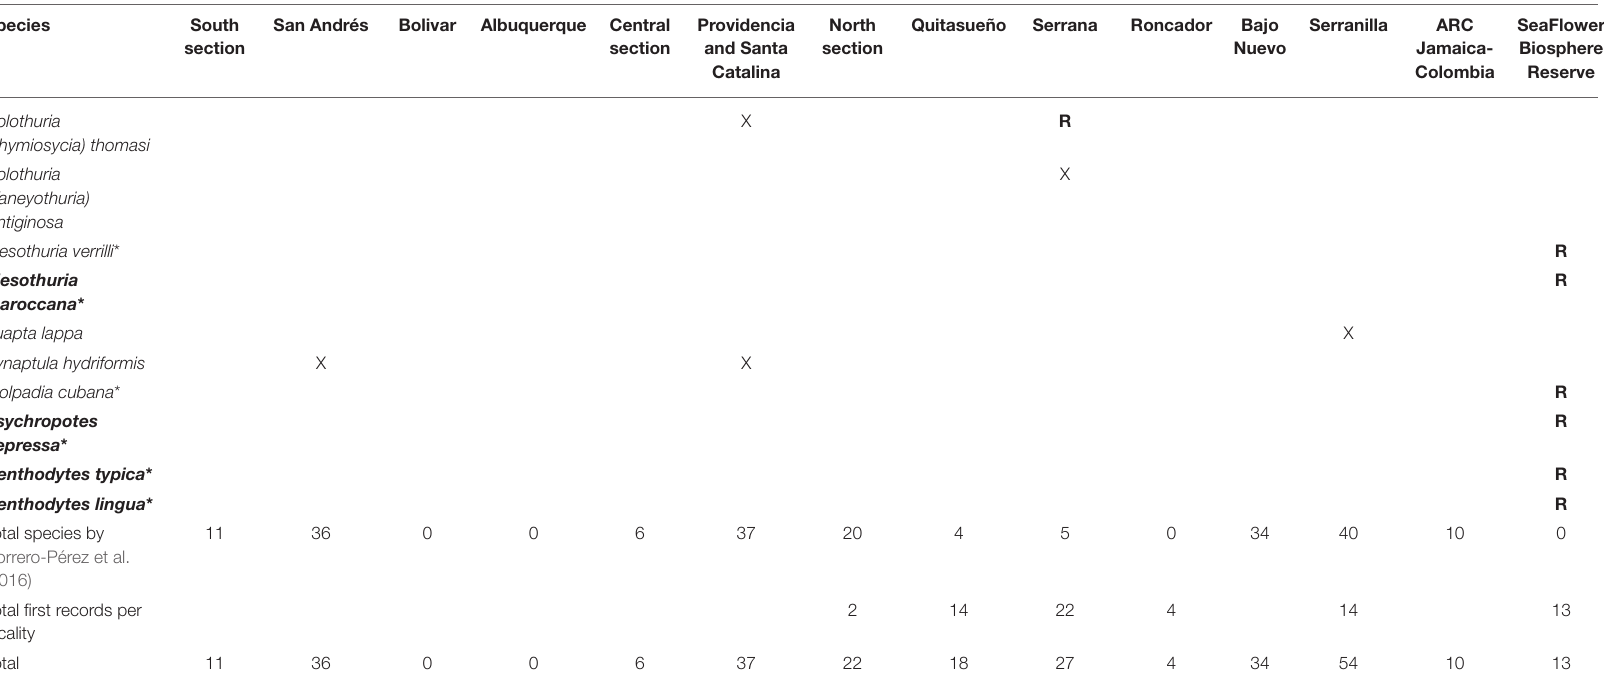
X indicates presence of the species accounted by Borrero-Pérez et al. (2016); R indicates first records for a locality; asterisk ( * ) in the species column indicates new records for SeaFlower Biosphere Reserve; and bold letter denote new records for Colombian Caribbean